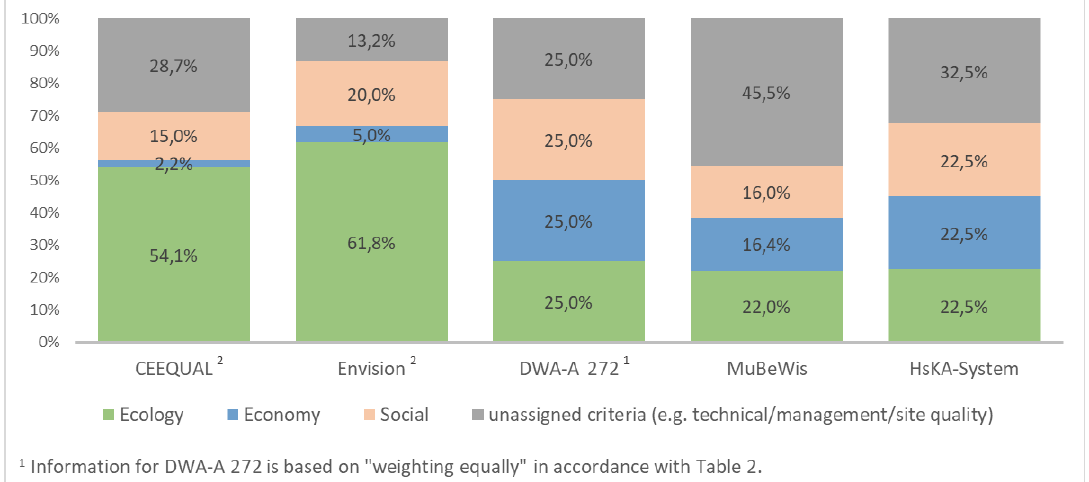
Figure 3. Number of criteria covering the three sustainability dimensions in different schemes.